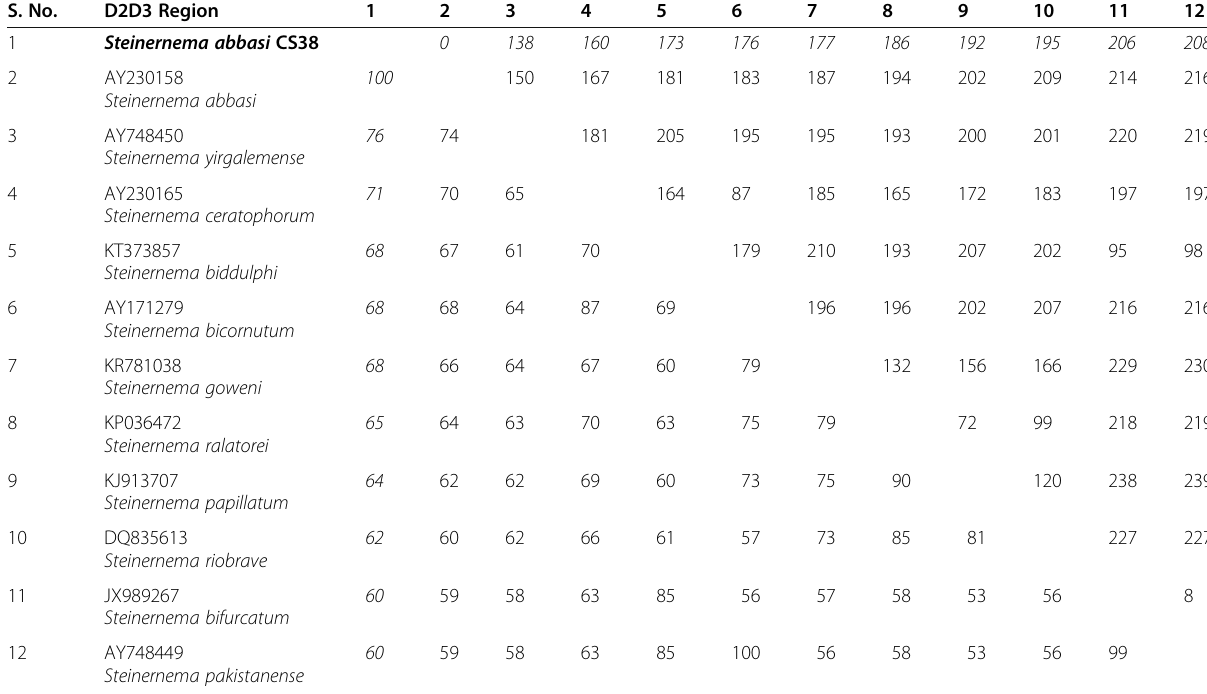
Table 6 Pairwise distances of the D2D3 region between Steinernema species from the “ bicornatum ” group S. No. D2D3